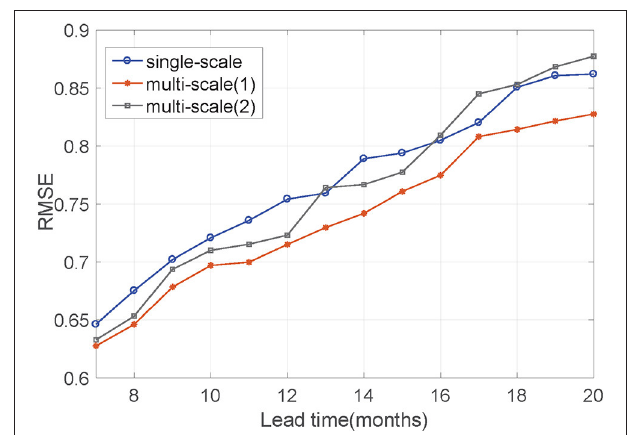
FIGURE 7 | Root Mean Square Error between predicted values and actual values with different relationships among lead months, input mesh size, and convolution kernel size. Their relationship determines the ratio of the receptive field size in the three prediction stages. Refer to Figure 6 for the information on the single-scale, multi scale (1), and multi scale